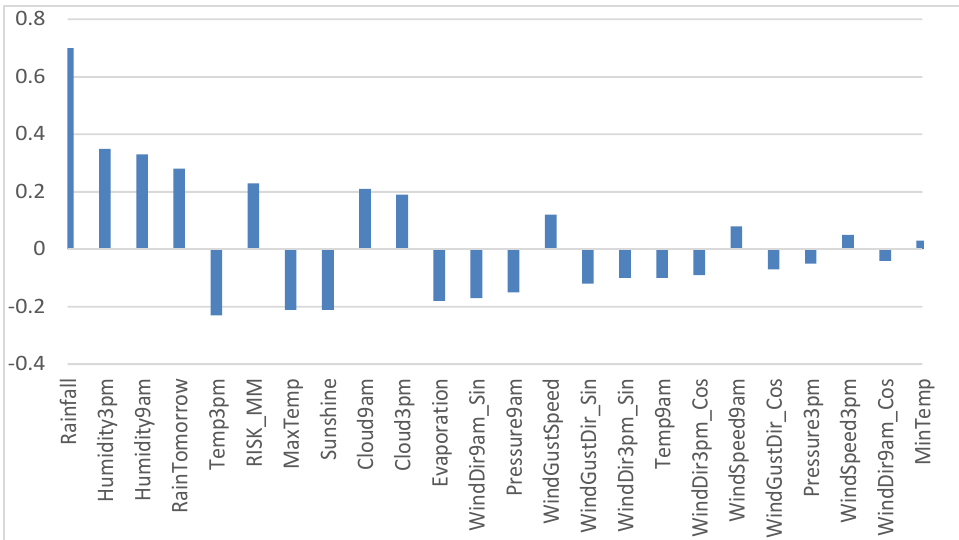
Figure 2. Correlation of RainToday with respect to the rest of variables.